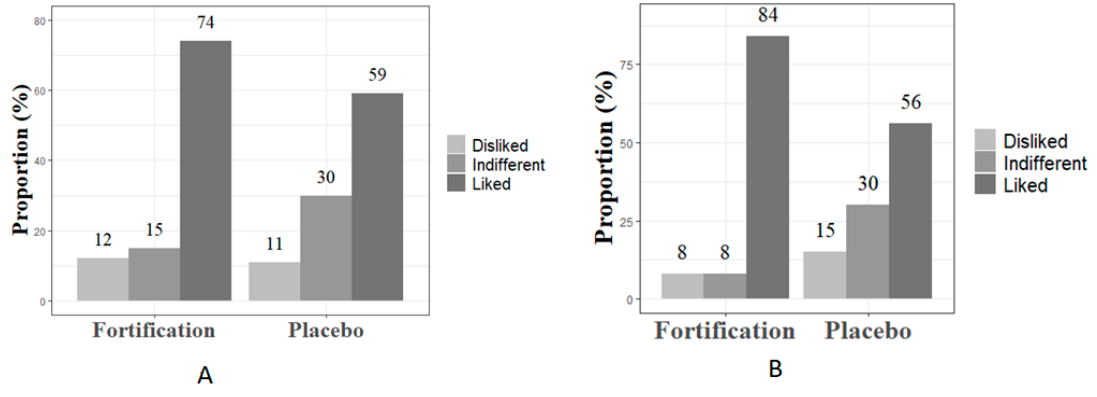
Figure 2. Milk acceptability between pregnant women with periodontitis from a low socioeconomic area in Rio de Janeiro, Brazil. Figure ( A ) = T0 and ( B ) = T1.